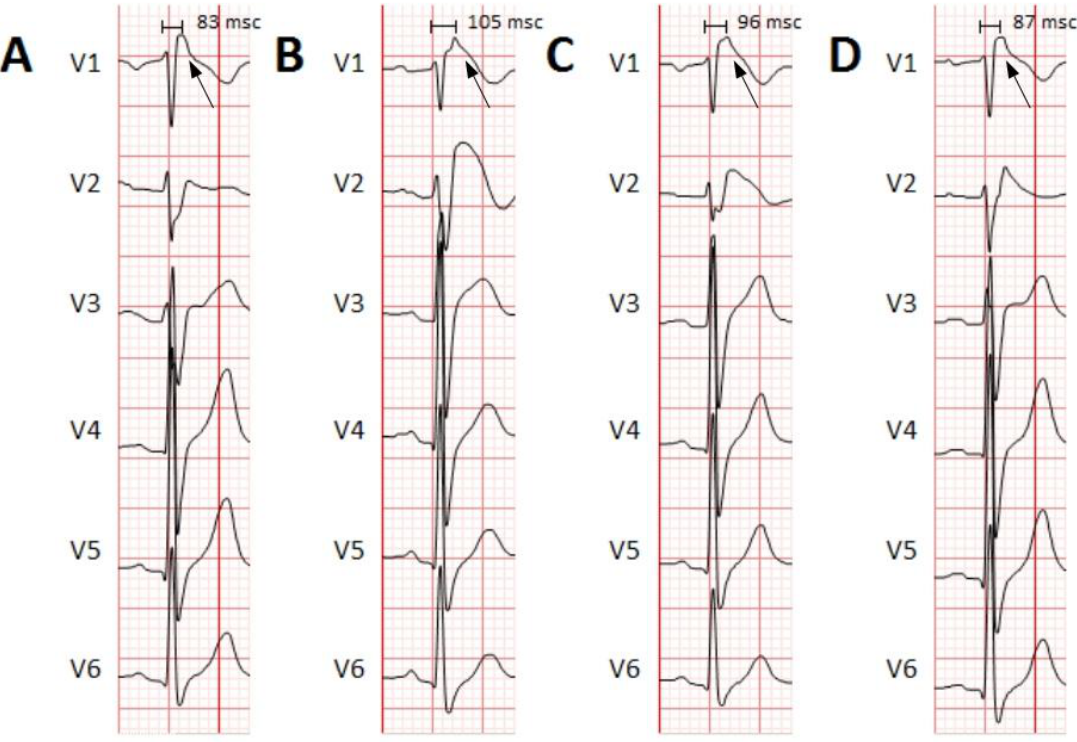
Figure 5. Example of different QRS complexes at different times in a patient with BrS. The precordial leads (V1 through V6) are shown. ( A ) Basal ECG, before Flecainide administration. Flecainide is an antiarrhythmic drug with major effects on cardiac cell’s depolarization. Due to its effects on the cardiac sodium channel (main alteration in BrS), it is used in patients with suspected BrS to unmask the characteristic electrocardiographic pattern. No Brugada pattern is observed. ( B , C ) ECG showing a Brugada pattern immediately and a few minutes after Flecainide administration. A moving wave becomes apparent with increasing delay (black arrows and time intervals). ( D ) Resumption to basal conditions demonstrating the returning of the moving wave to more proximal parts of the QRS. BrS: Brugada syndrome. ECG: electrocardiogram.